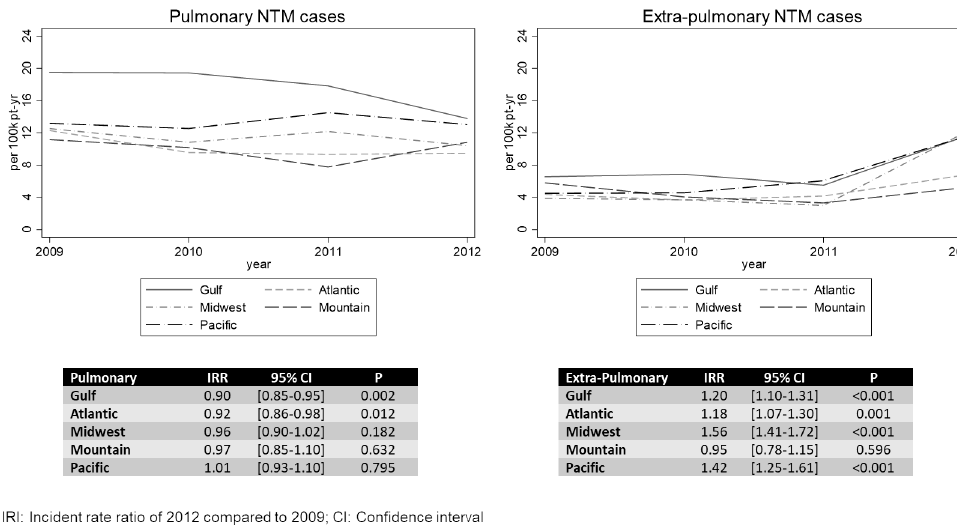
Fig 2. Incidence rates of NTM cases per 100,000 patient-years receiving care in VA over